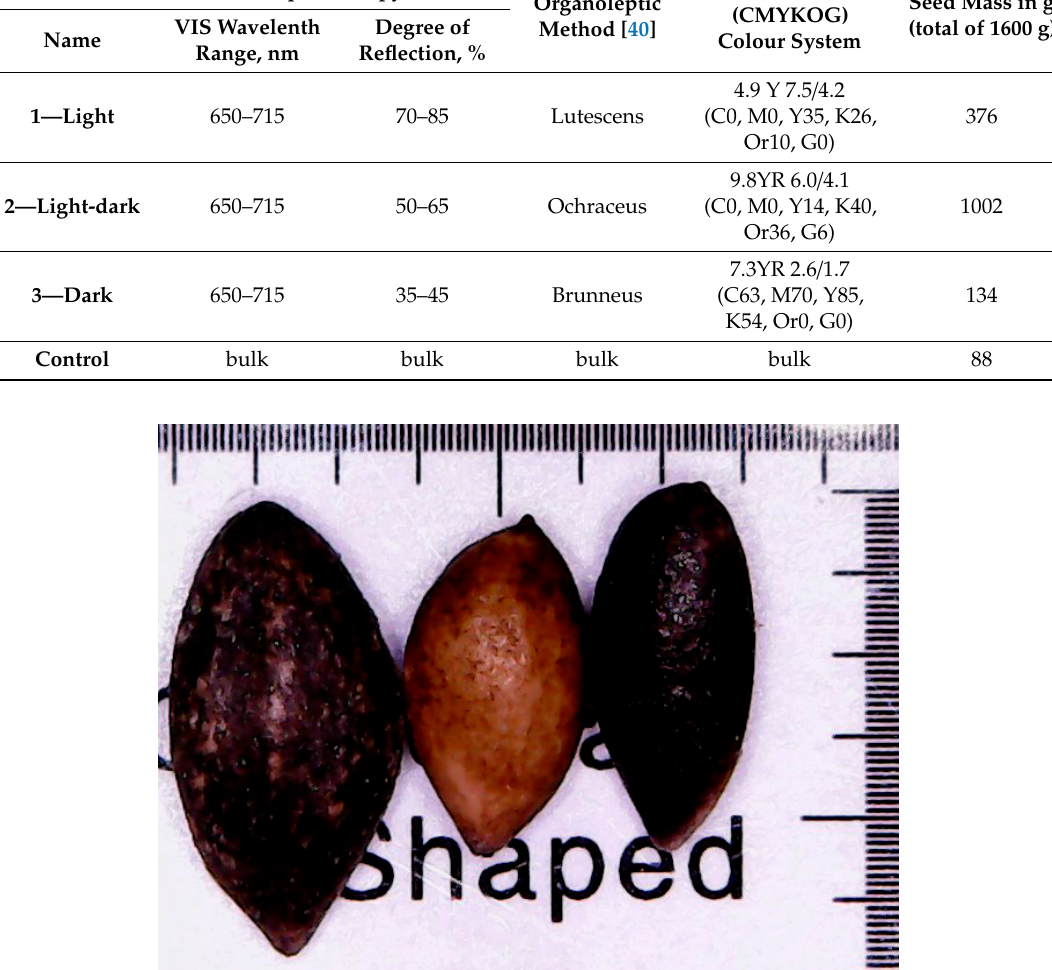
Table 1. Colour classes and sample optical features of Pinus sylvestris L. seed used in the study. Seed Colour Class (VIS-spectroscopy) [25]